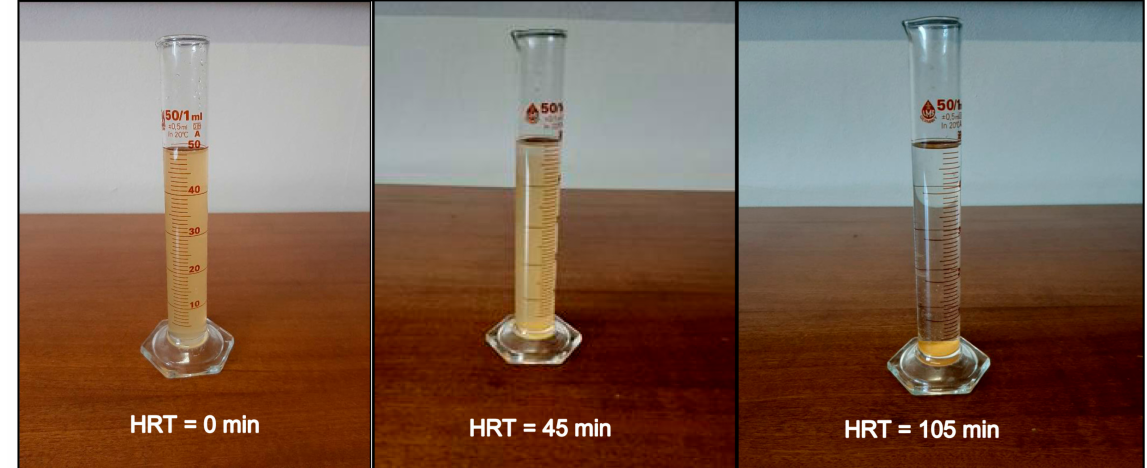
Figure 5. Settleability of pre-treated